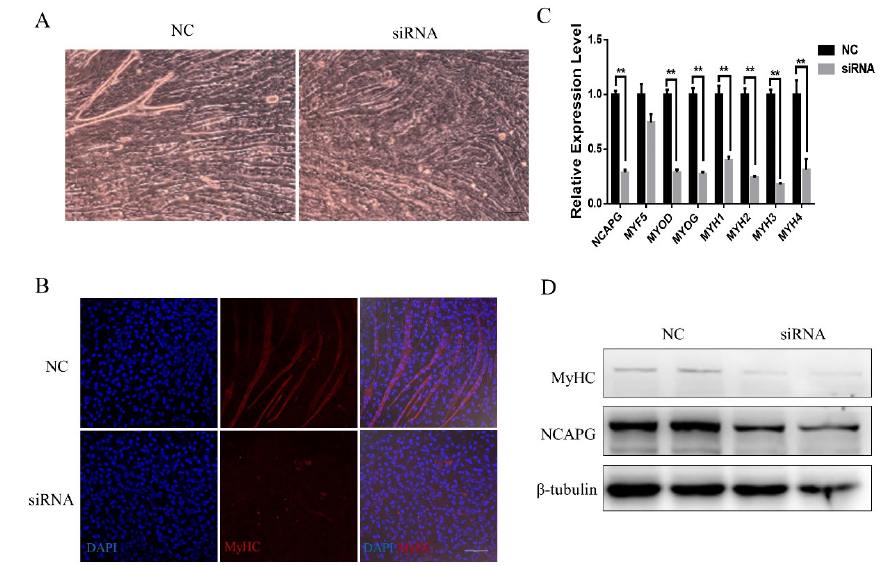
Figure 3. Silencing NCAPG impaired the differentiation of myoblasts. ( A ) Cell morphology of NCAPG-silenced myoblasts on day 4 of differentiation. Scale bar = 100 µm. ( B ) NCAPG-silenced myoblasts on day 4 of differentiation. Myotubes were visualized using IF staining with MYH antibodies. Scale bar = 100 µm. ( C ) Transcript levels of muscle-specific genes on day 4 of differentiation. The results are presented as the mean ± the SEM from at least three independent experiments: ** p < 0.01. ( D ) Western blot evaluating the protein levels of NCAPG and MHCs in myoblasts on day 4 of differentiation.